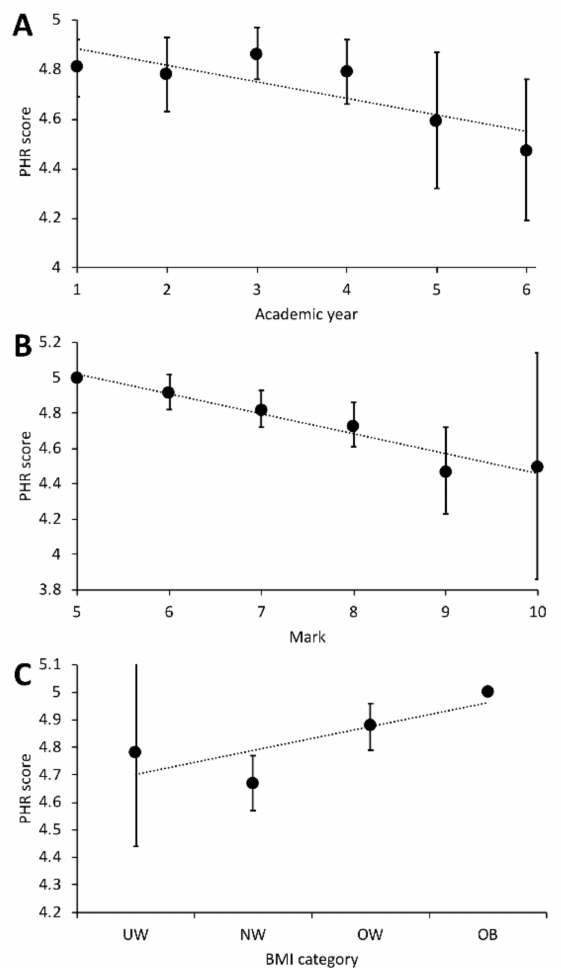
Figure 5. Students’ average potentially harmful response (PHR) score at baseline by academic year ( A ), mark ( B ) and body mass index (BMI) ( C ). BMI categories: underweight (UW), normal weight (NW), overweight (OW) and obese (OB). Error bars represent the 95% confidence